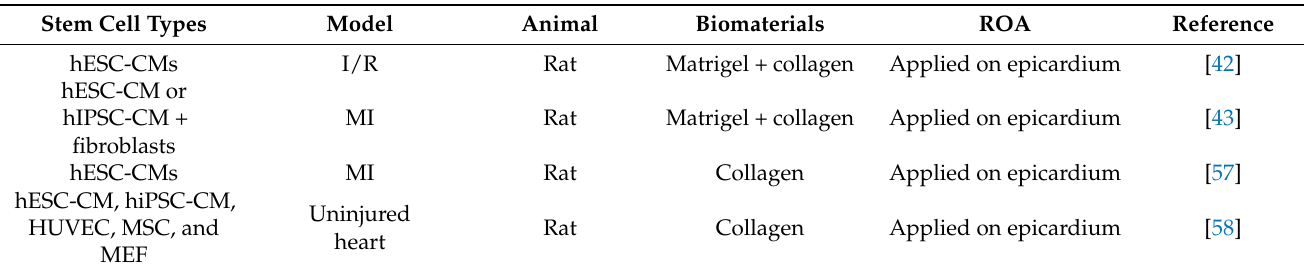
Table 2. Tissue engineering using PSC derived cardiovascular cells for treatment of MI in small animal models. Stem Cell